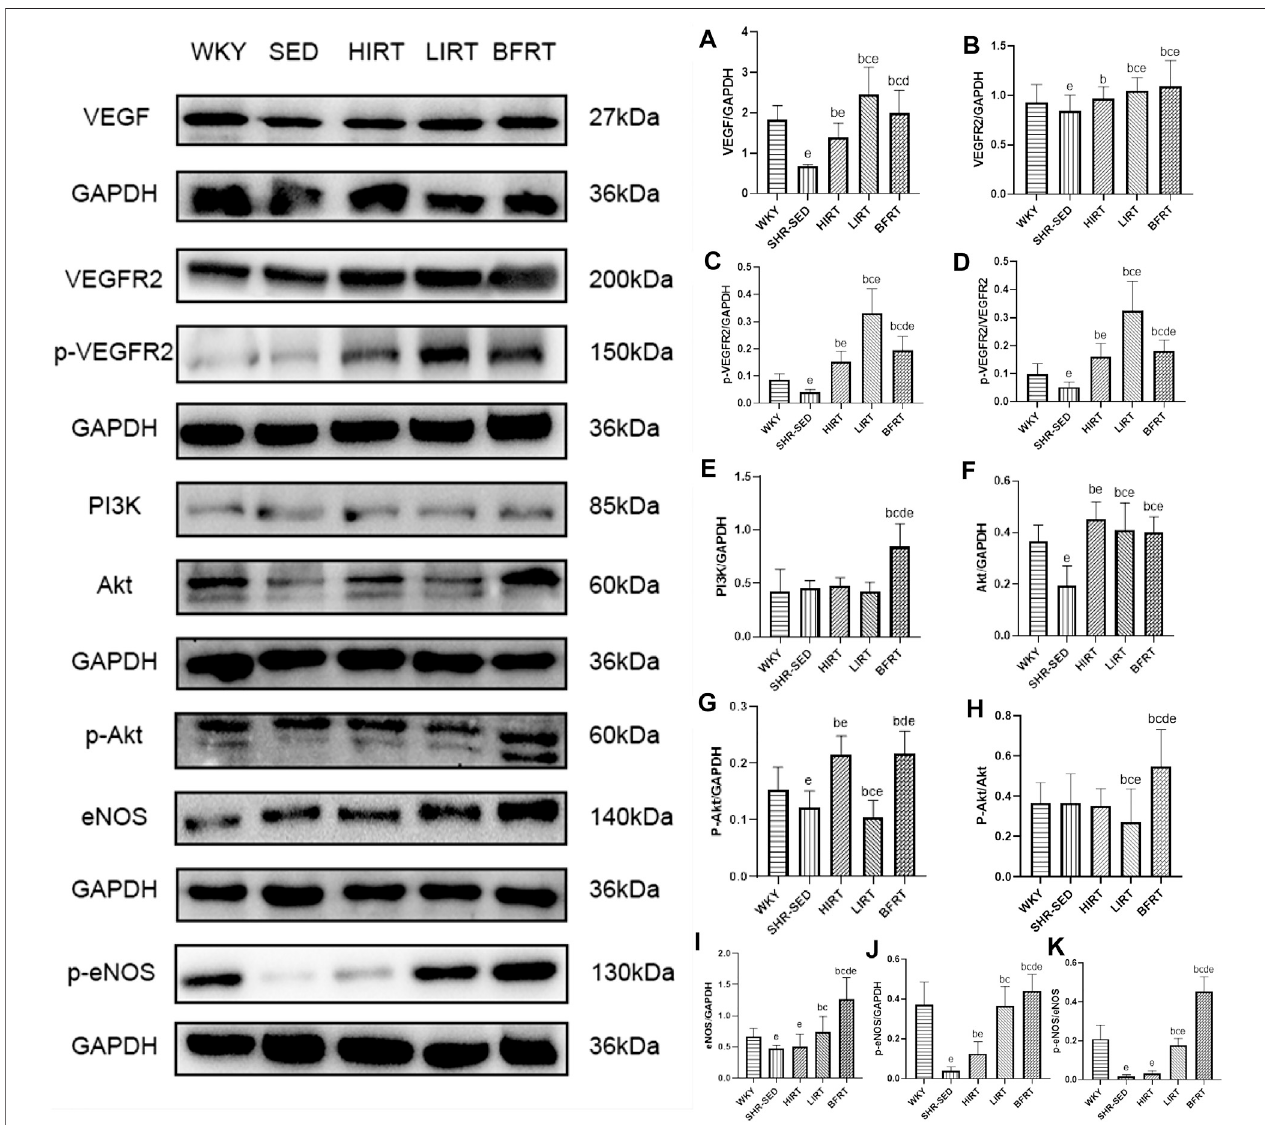
FIGURE 3 | VEGF-Pi3k-Akt-eNOS protein expression in left ventricular tissues. (A) , VEGF/GAPDH; (B) , VEGFR2/GAPDH; (C) , p-VEGFR2/GAPDH; (D) , p-VEGFR2/VEGFR2; (E) , PI3K/GAPDH; (F) , Akt/GAPDH; (G) , p-Akt/GAPDH; (H) , p-Akt/Akt; (I) , eNOS/GAPDH; (J) , p-eNOS/GAPDH; (K) , p-eNOS/eNOS.